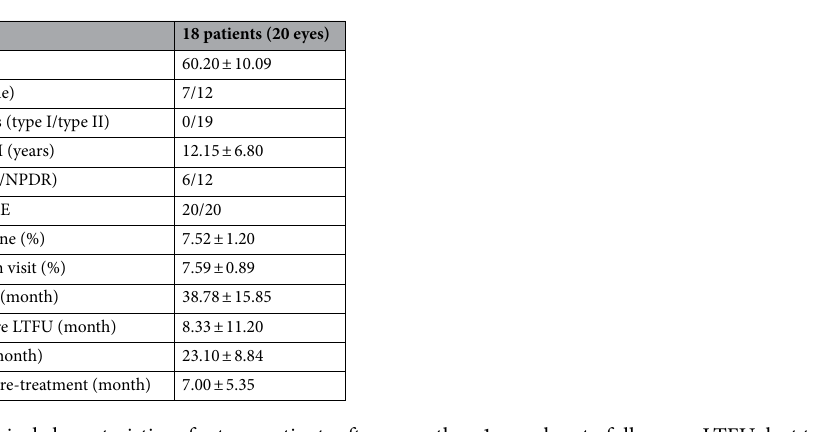
Table 2. Clinical characteristics of return patients after more than 1-year loss to follow-up. LTFU; lost to follow-up.